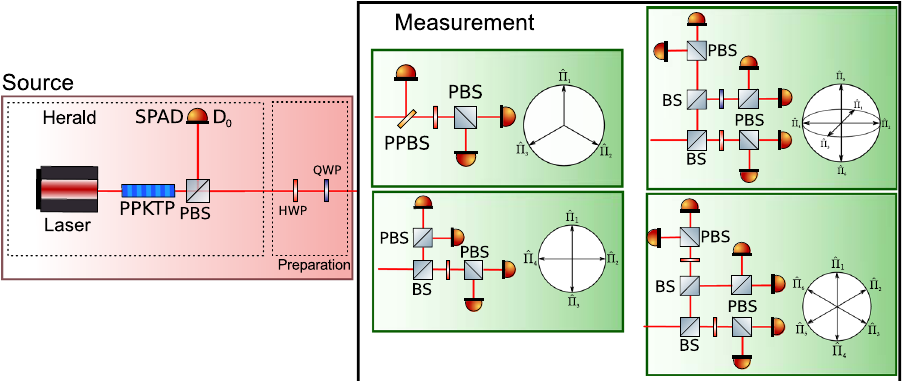
Fig. 4 Experimental setup. An heralded single photon source made from a Periodically Poled Potassium Titanyl Phosphate (PPKTP) crystal in a Sagnac interferometer, generates single photons at 808 nm. After the polarizing beam splitter (PBS), the heralded photon is prepared in any desired polarization by using an Half-Wave Plate (HWP) and a Quarter-Wave Plate (QWP). The photon is then measured using Single Photon Avalanche Diodes (SPAD) with four different POVM con fi gurations with 3, 4, and 6 outcomes. The coincidences between the heralding photon detector D 0 and the detectors in the measurement station are recorded by a timetagger on N → ∞ the min-entropy tends to H min ( X ∣ E ) → ∞ , showing that